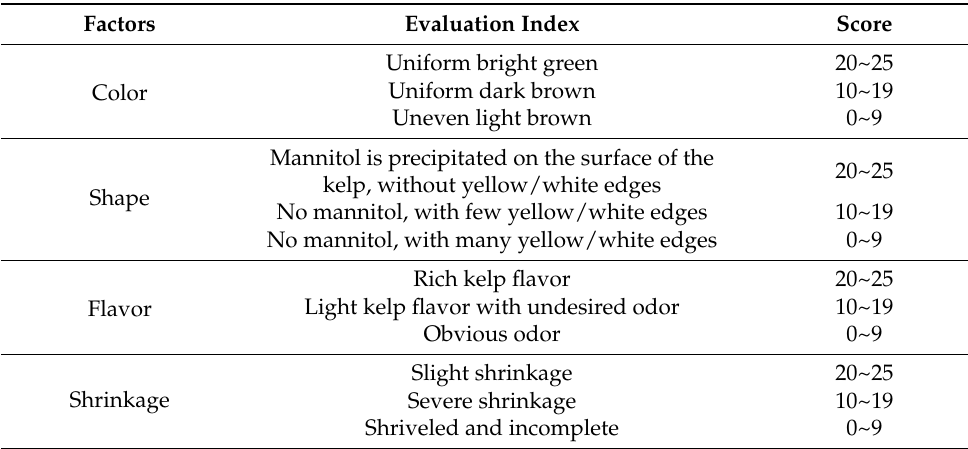
Table 4. Sensory evaluation criteria for the dried